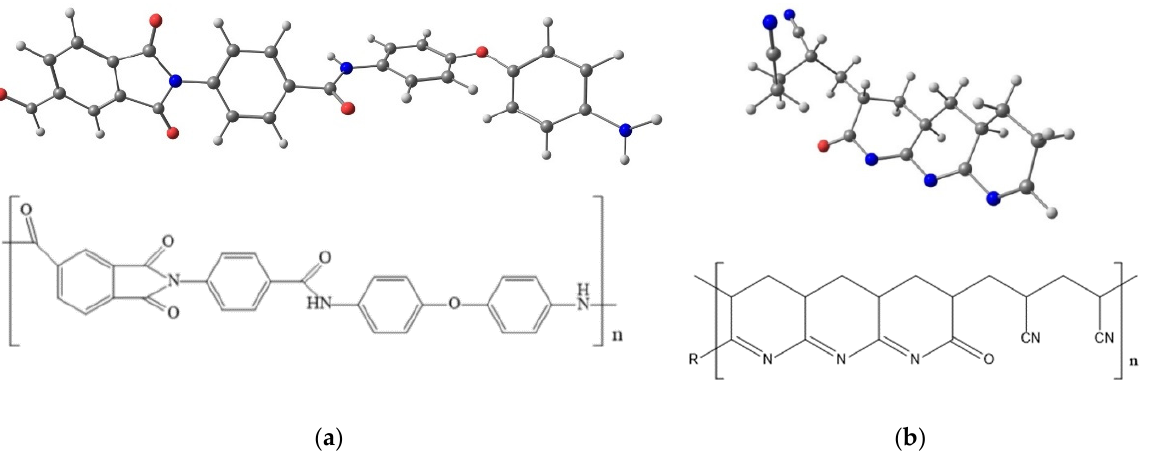
Figure 1. Molecular structures of ( a ) PAI and ( b ) c